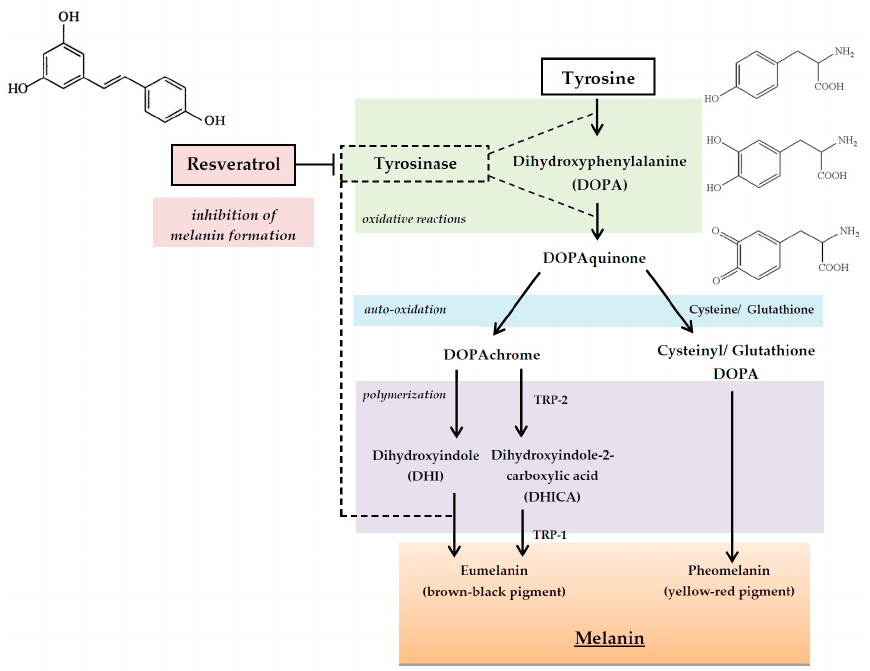
Figure 6. The involvement of the tyrosinase in the reaction of melanin synthesis and the inhibition of melanogenesis by the substrate analog inhibitor, i.e. , resveratrol. The black arrows indicate the direction of the reaction, the dash line indicates the involvement of the enzyme tyrosinase and the sign in the letter “T” shape indicates the inhibition of the tyrosinase by resveratrol.